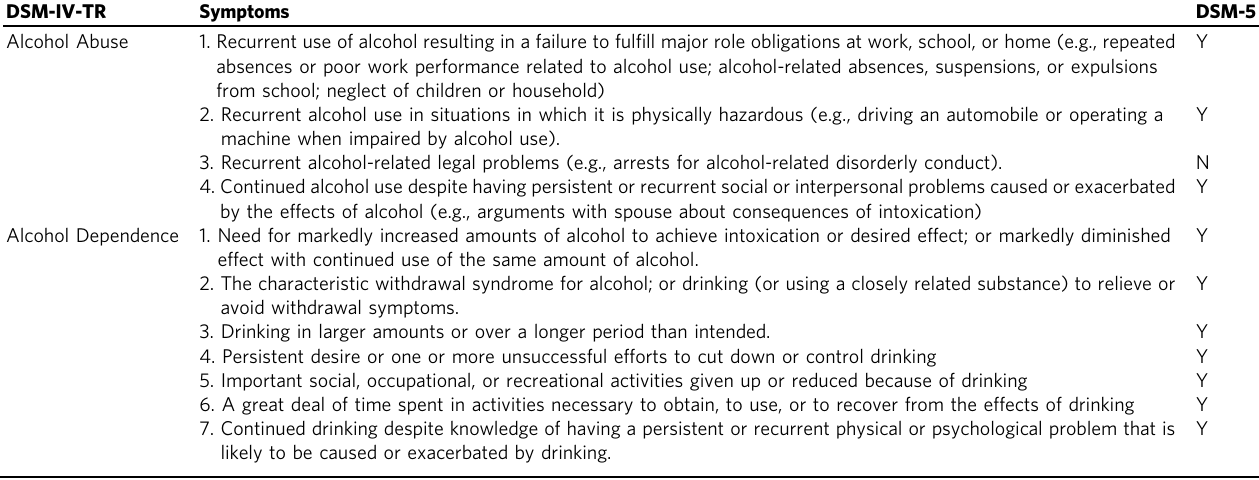
Table 3 List of AUD symptoms as described in the